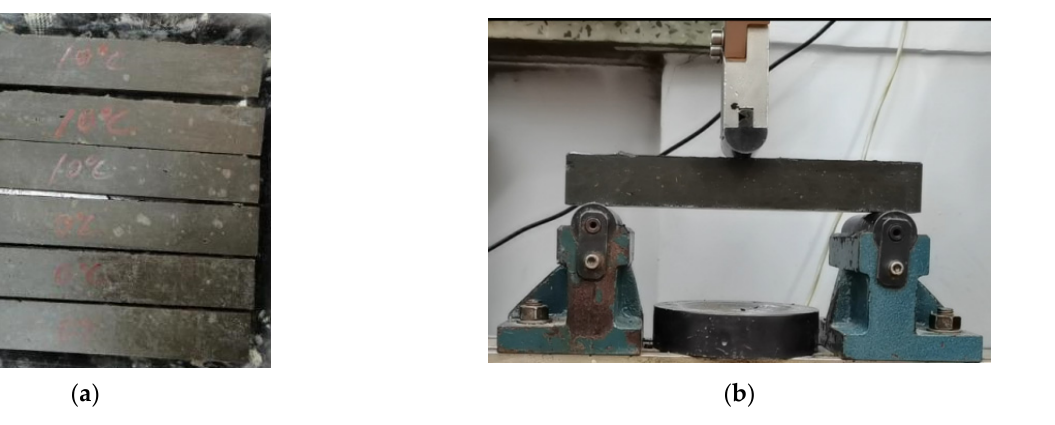
Figure 7. Flexural tensile strength test piece and test process. ( a ) Test specimen; ( b ) Test